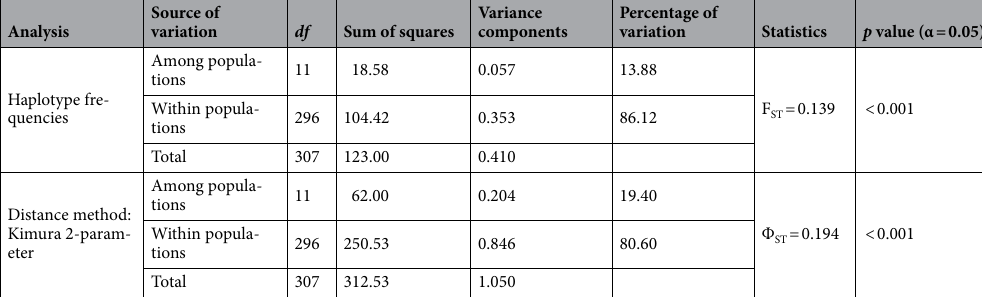
populations is summarized in Table 4. A total of 100 alleles were detected across all loci, 16 of those alleles were private and all four populations exhibited private alleles. Microsatellite locus CCo8 was the most variable with